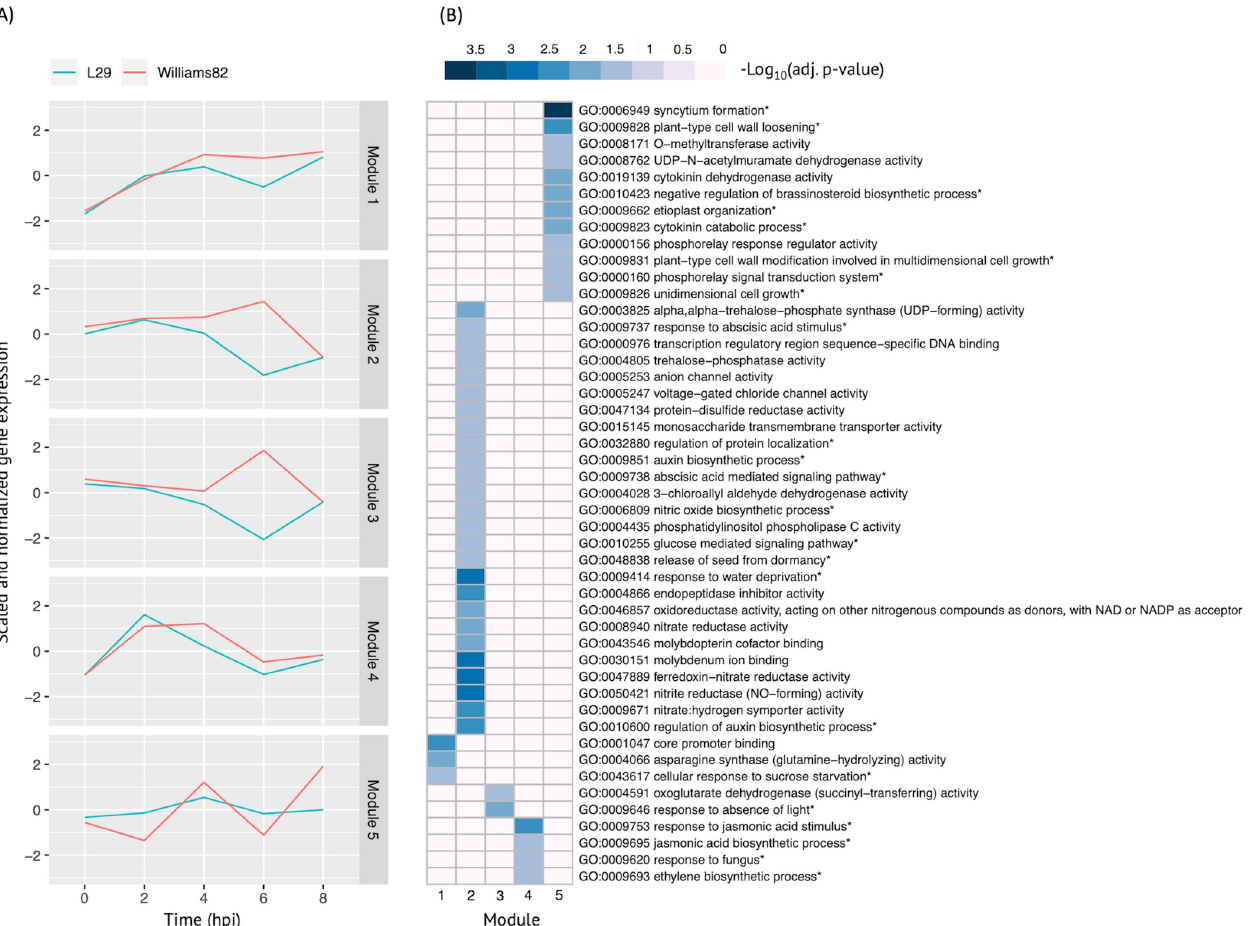
Fig 2. Co-expression gene modules and their biological functions. A module is defined as a group of genes sharing similar expression profiles over time and likely involved in the same biological processes. The expression profile for these modules was determined by averaging the expression levels of DEGs within each module. (A) Mean module expression profiles of L29 and Williams82 over time. Normalized expressions of DEGs were used for clustering with Gaussian-finite mixture modeling. (B) Heatmap of GO functional enrichment analyses. Columns represent module groups. Rows represent hierarchical clustering of enriched GO categories; those with an asterisk indicate a biological process, while all others are molecular functions. Color represents–log 10 adjusted p-value.